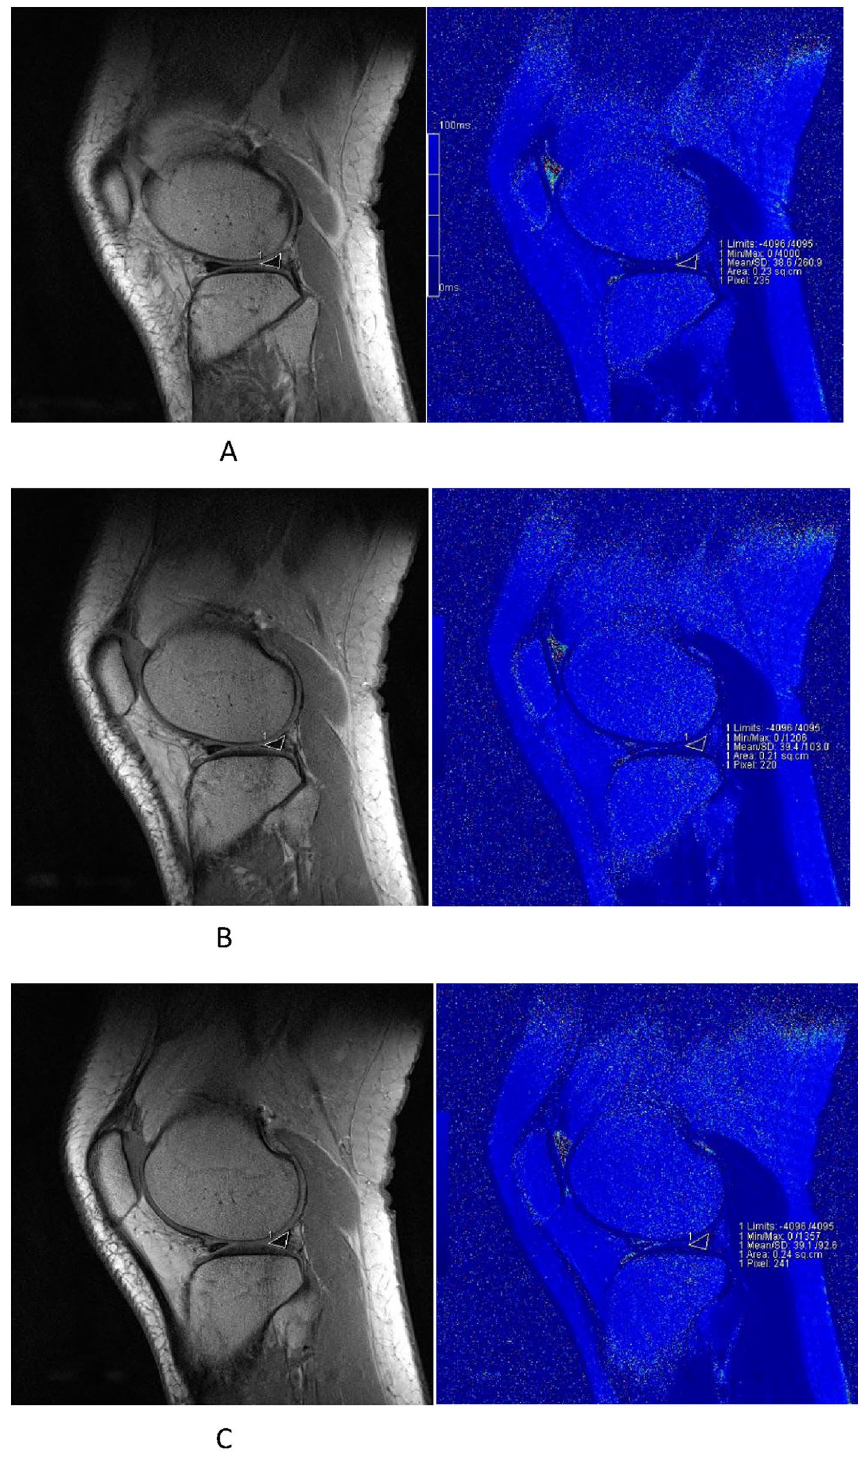
Figure 1. Representative images for image analysis. These figures show the left knee in a 23-year-old male before the marathon. pseudo-color images were synchronized with the anatomical images. Three adjacent maximum planes of LMPH were selected; the regions of interest were delineated manually along the edge of the meniscus on the anatomical images; and T2 values were obtained via T2 mapping, accordingly. ( B ) is the medial plane; ( A ) and ( C ) are adjacent planes of ( B ). The T2 values were 38.6 ms, 39.4 ms, 39.1 ms,